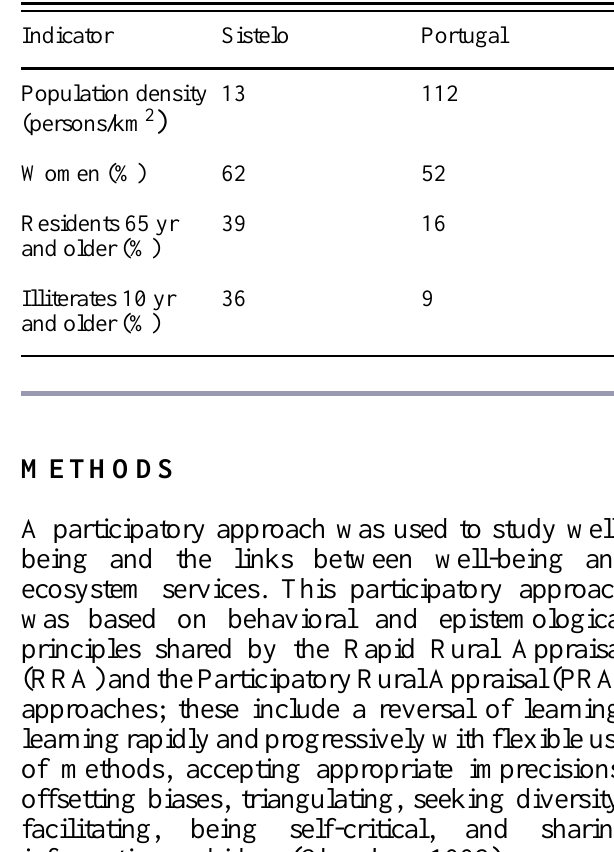
Table 1 . Comparison of some Sistelo sociodemographic indicators with Portuguese national